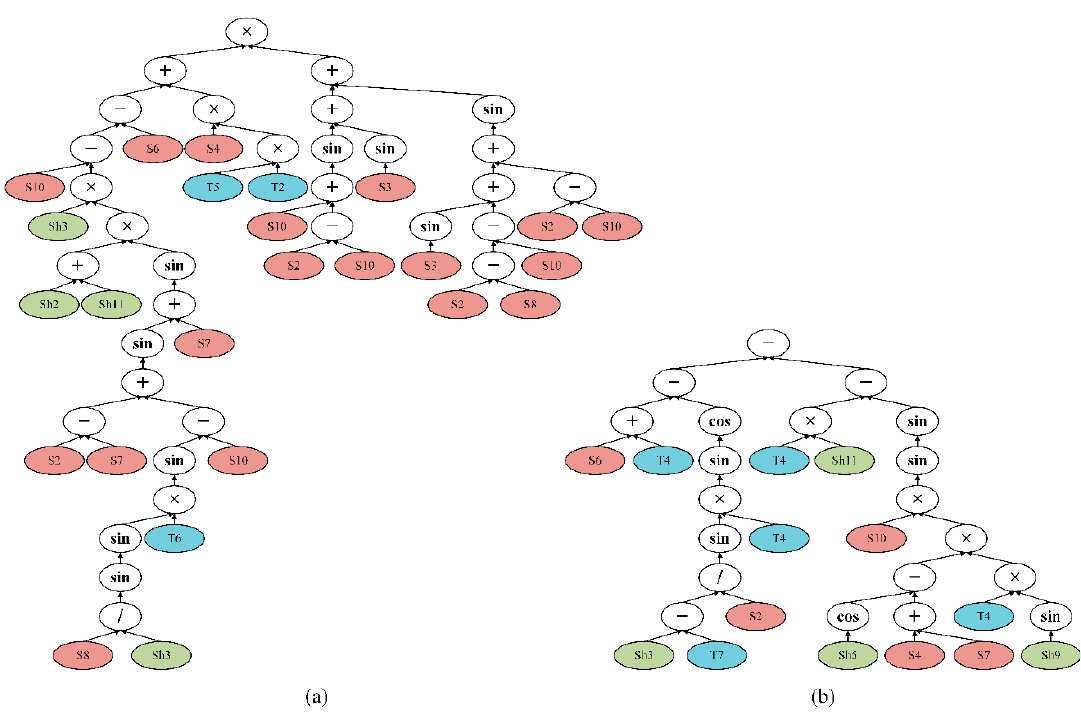
Figure 9. The best GP individuals in Area 1 ( a ) and Area 2 ( b ). The colored leaf nodes represent terminals, while the white internal nodes represent functions.